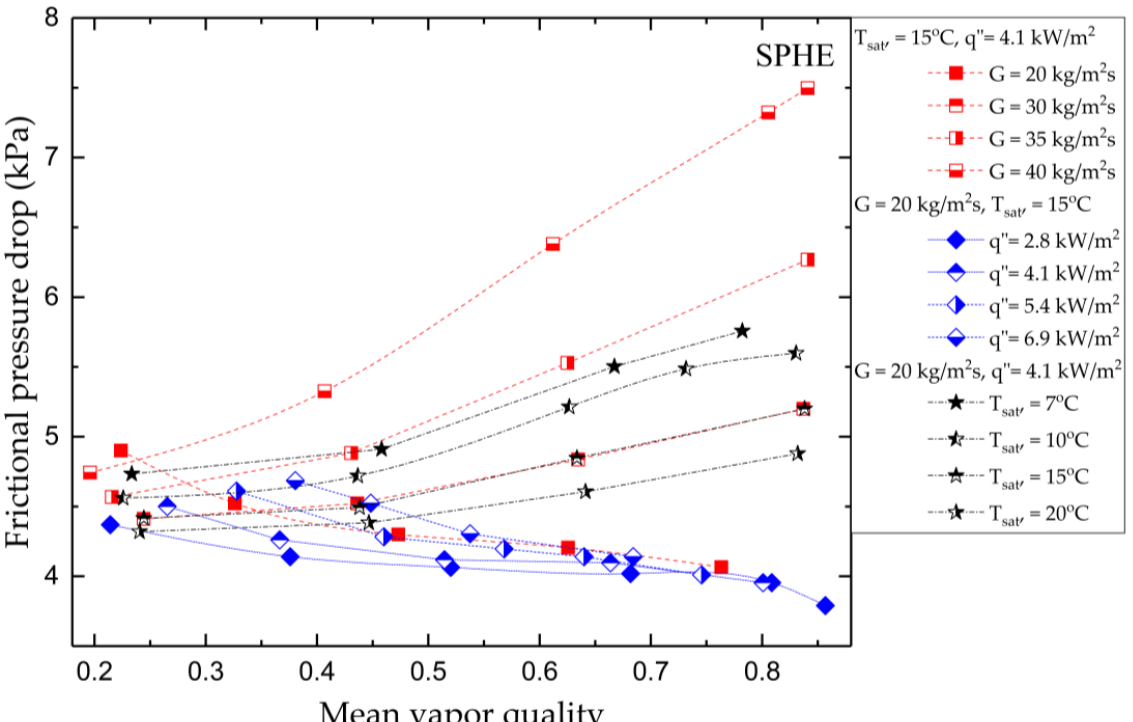
Figure 19. Average evaporation HTC comparison of R-1234ze(E) at variable operating conditions in the SPHE [15] .